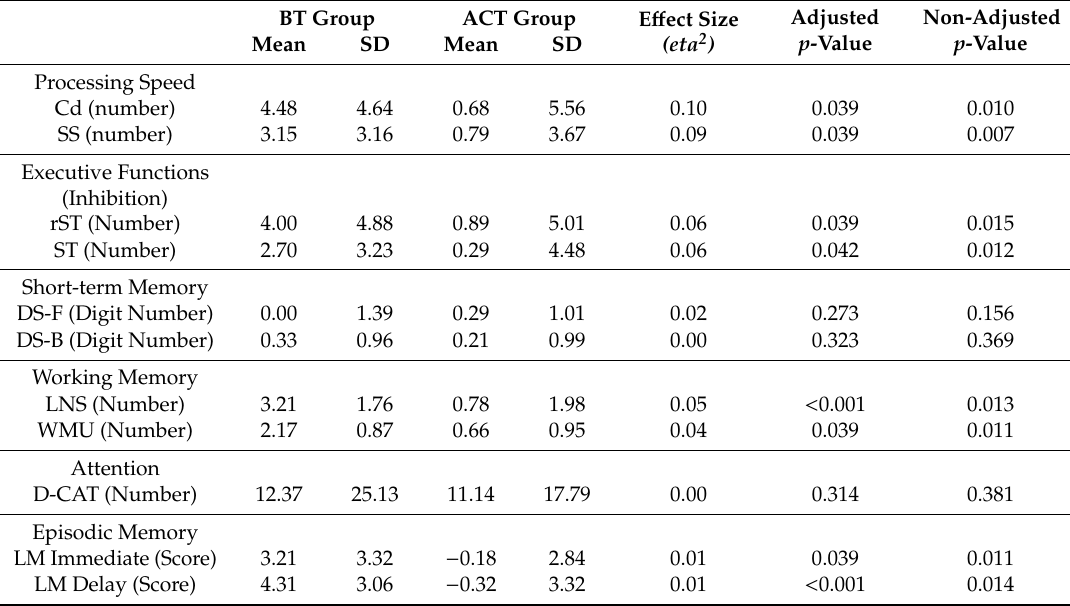
Table 2. Change scores of cognitive function of both